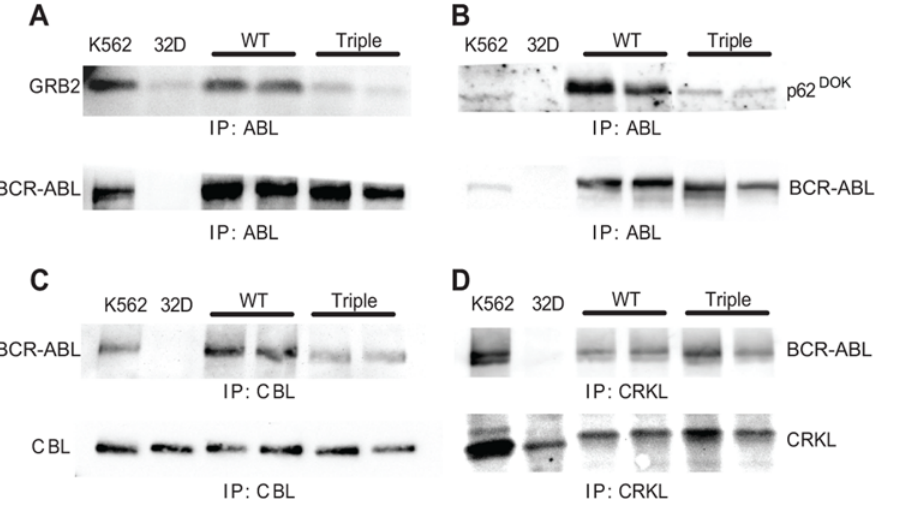
Figure 3. Interaction of BCR-ABL with various adaptor proteins is reduced, but not eliminated in the triple mutant. Lysates from the BCR-ABL expressing 32D cell lines, control line K562 and parental 32D cells were immunoprecipitated (IP) for the indicated proteins and blotted to determine interactions between BCR-ABL and (A) GRB2; (B) p62 DOK ; (C) CBL; and (D) CRKL. Lower panels show normalization for levels of immunoprecipitated proteins: (A and B) BCR-ABL, (C) CBL and (D) CRKL. In (D), the increased amount of BCR-ABL in the triple mutant lane on the left compared to the outermost lane reflects the correspondingly greater amount of immunoprecipitated CRKL in this lane.